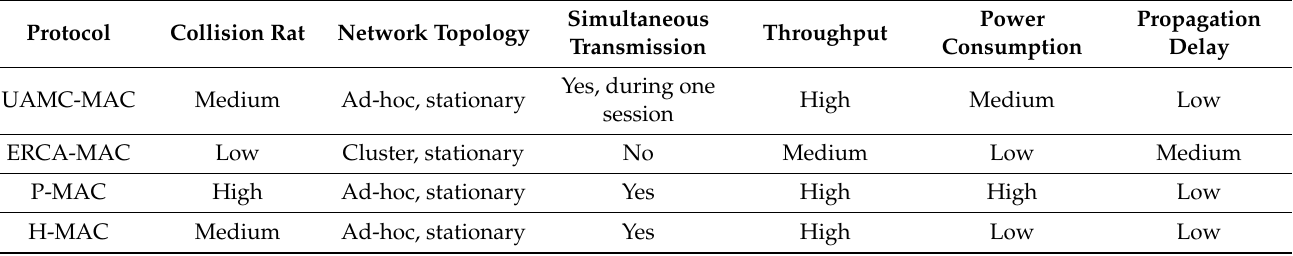
Table 5. Cross correlation between UAMC-MAC, ERCA-MAC, P-MAC and H-MAC protocols.